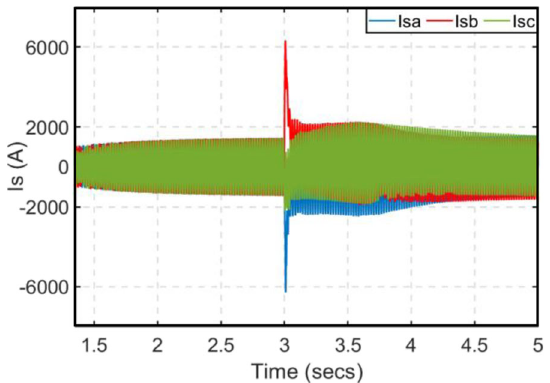
Fig. 12 Evolution of the DC bus voltage